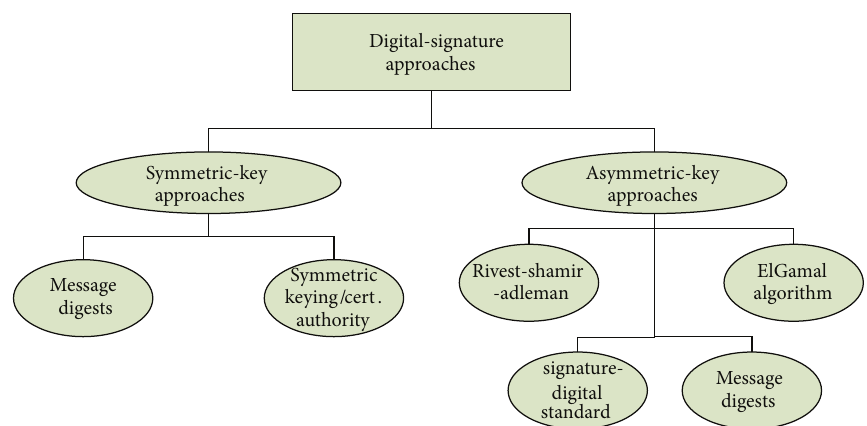
Figure 1: Classification of traditional digital-signature schemes.